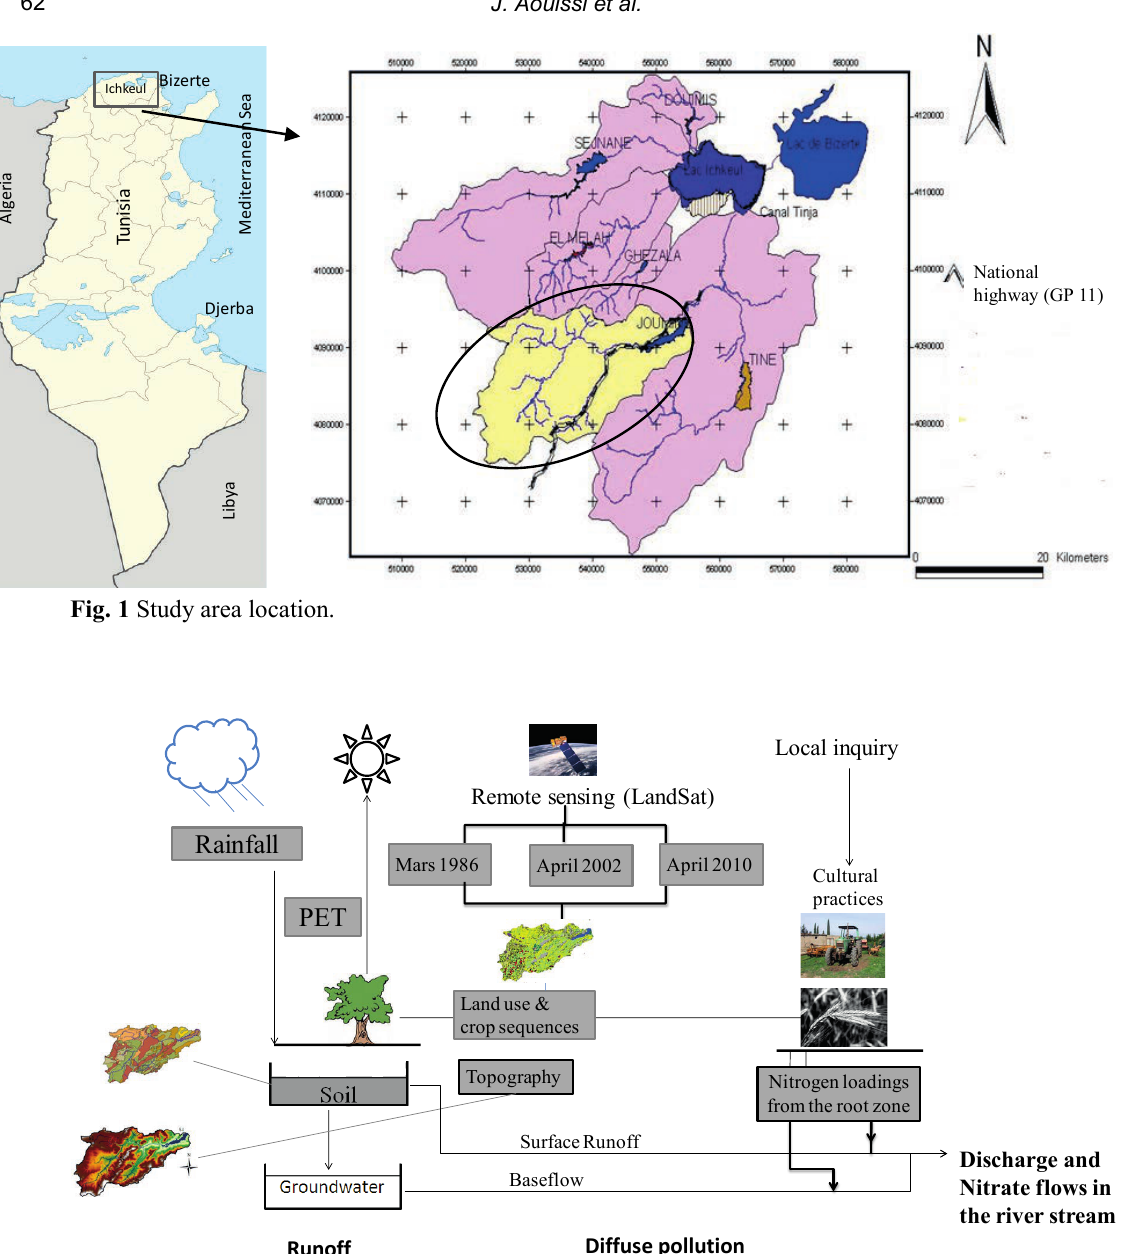
Fig. 2 Diagram showing the SWAT model application (adapted from Laurent and Ruelland